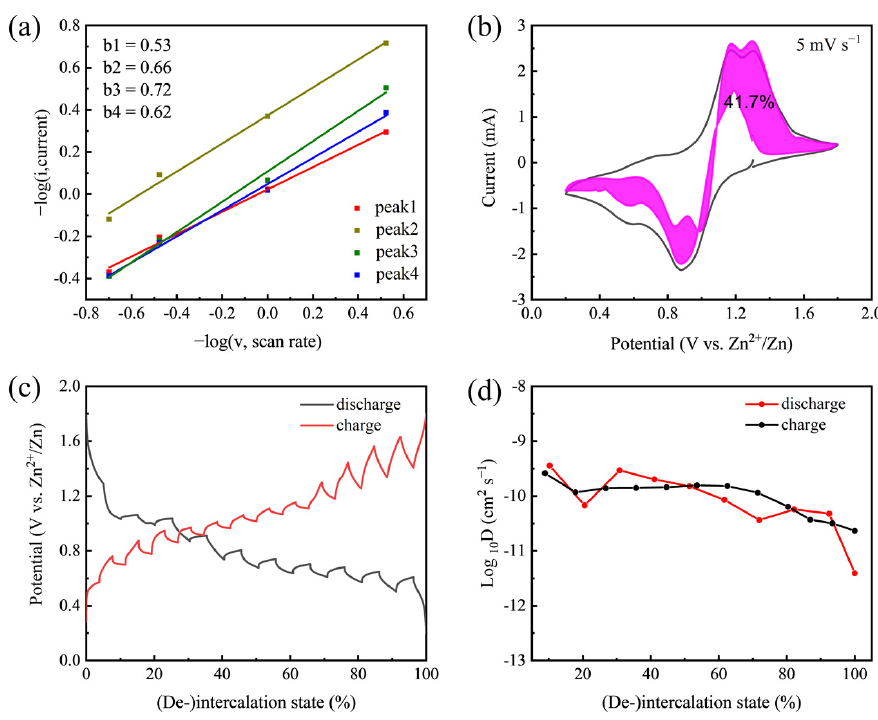
Figure 3. ( a ) The plots of–log ( i ) versus–log ( v ) of cathodic and anodic peaks. ( b ) Capacitive contribution (pink part) and diffusion-controlled contribution (void part) at 5 mV s − 1 . ( c ) Discharge–charge curves of V 2 O 5 · n H 2 O nanorods in GITT measurement. ( d ) The diffusion coefficients of Zn 2+ upon the 2nd discharge and charge progresses of the V 2 O 5 · n H 2 O nanorods. In order to obtain the Zn 2+ ion diffusion coefficient of V 2 O 5 nanorod electrodes, GITT tests were carried out during the second cycle (Figure 3c). The corresponding diffusion coefficient of Zn 2+ (D Zn ) during the second cycle was calculated to estimate the kinetics of V 2 O 5 · n H 2 O nanorods, which was in the range of ca. 10 − 9 –10 − 11 cm 2 s − 1 (Figure 3d) and was higher than the that of bulk V 2 O 5 [39]. The Zn 2+ ion diffusivity on discharging at